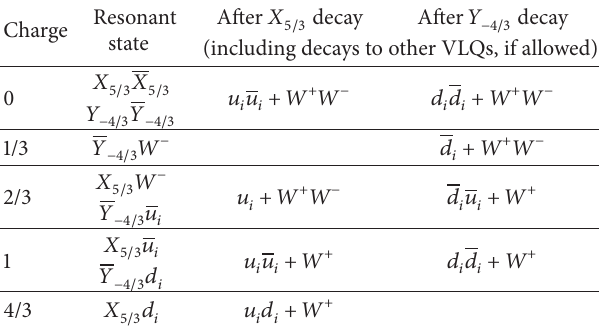
Table 4: Production and decay channels for 𝑋 5/3 and 𝑌 −4/3 . Only configurations with Q ≥ 0 have been shown for